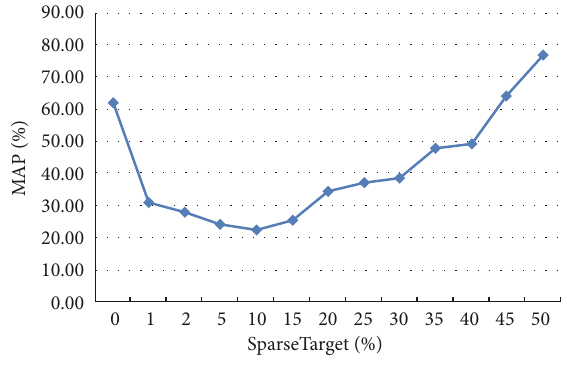
Figure 4: Sparse parameter of SSAEs.